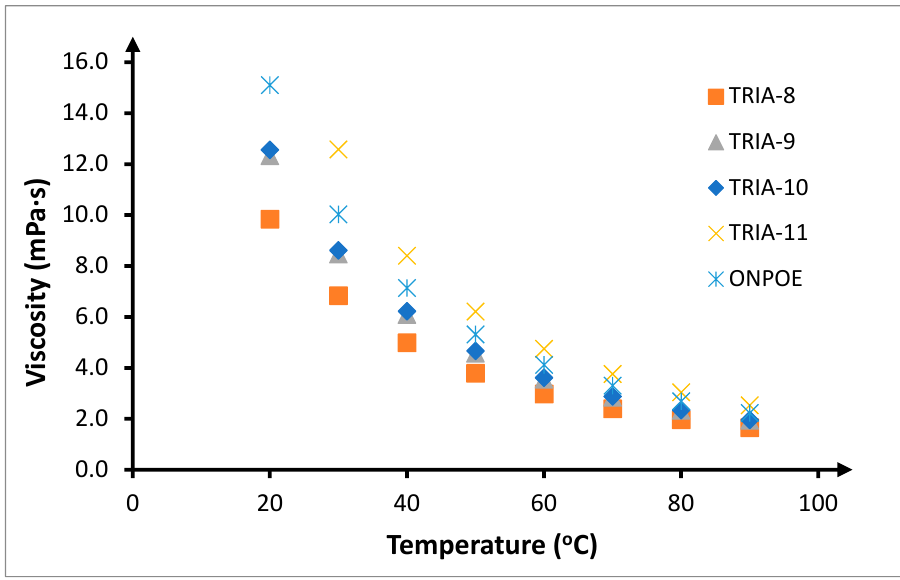
Figure 13. Viscosity dependence of TRIA-n (n = 8, 9, 10, 11) and ONPOE on temperature.